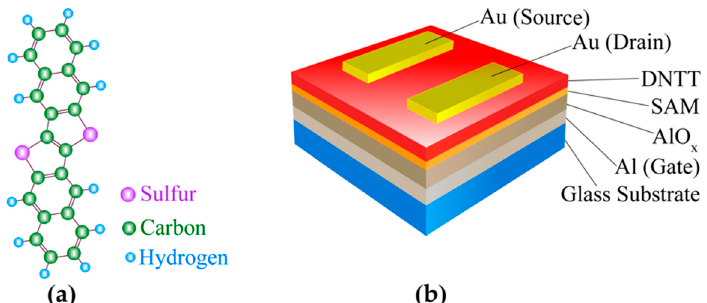
Figure 1. ( a ) Molecular structure of dinaphthothienothiophene (DNTT). Purple, green, and blue circles represent sulfur, carbon, and hydrogen atoms, respectively; ( b ) A schematic of a fabricated DNTT organic field-effect transistor (OFET) device.